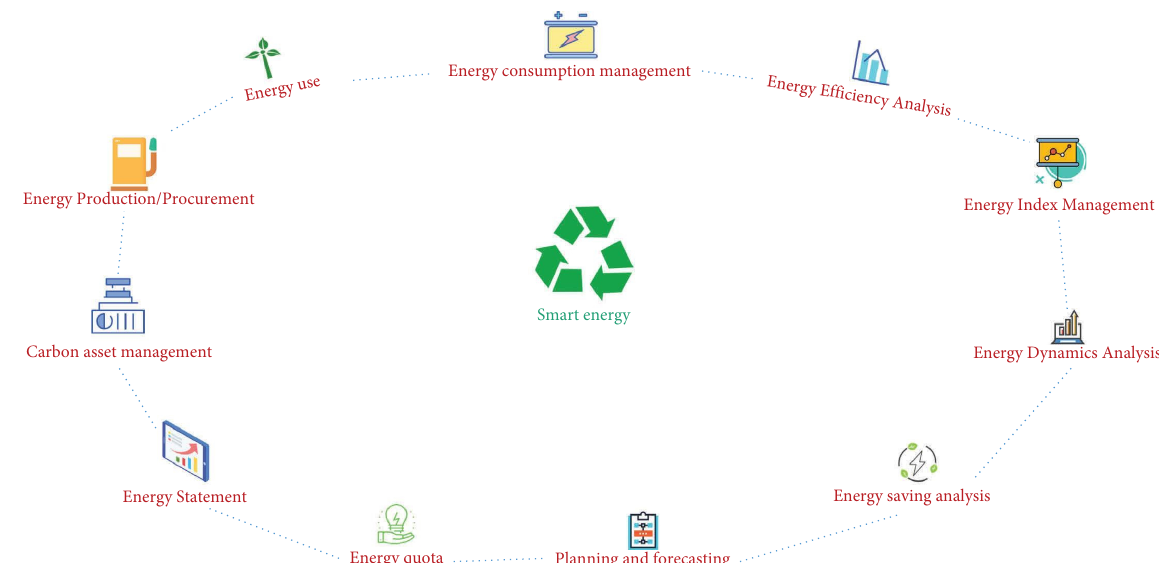
Figure 1: Energy economic